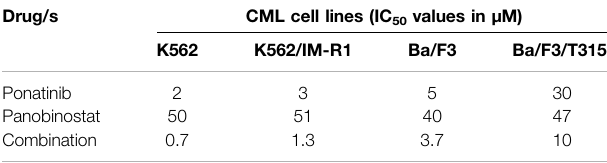
TABLE3| ThisdatahasbeenextractedfromMatsudaetal.(2016).For72 h,cells were exposed to the same concentration of ponatinib, panobinostat, or their combination, before being tested using XTT assay.